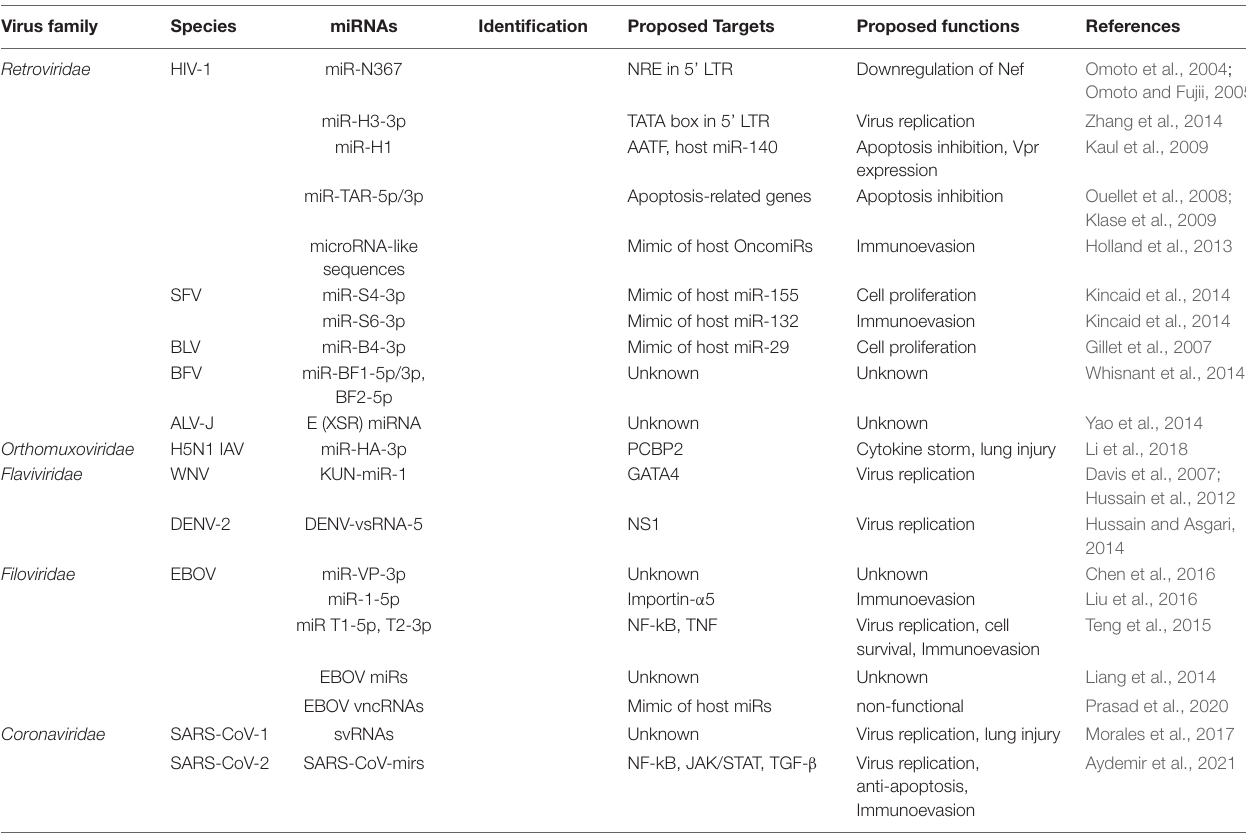
TABLE 1 | RNA virus-encoded